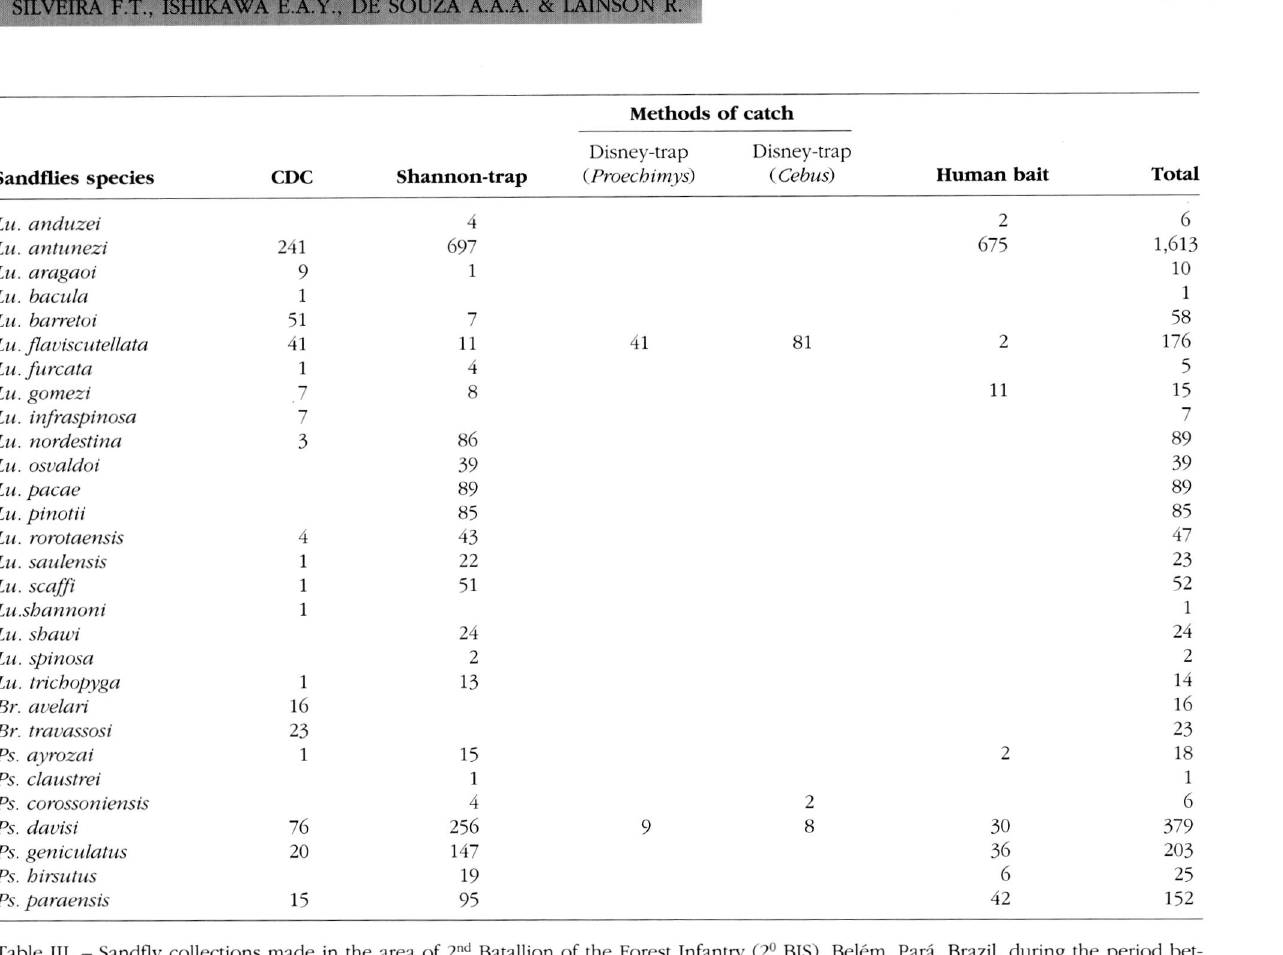
attached to the wall of the hind-gut, particularly the pylorus